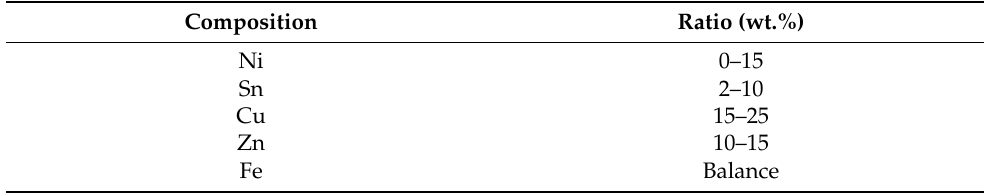
Table 1. The composition ratio of pre-alloyed powder.